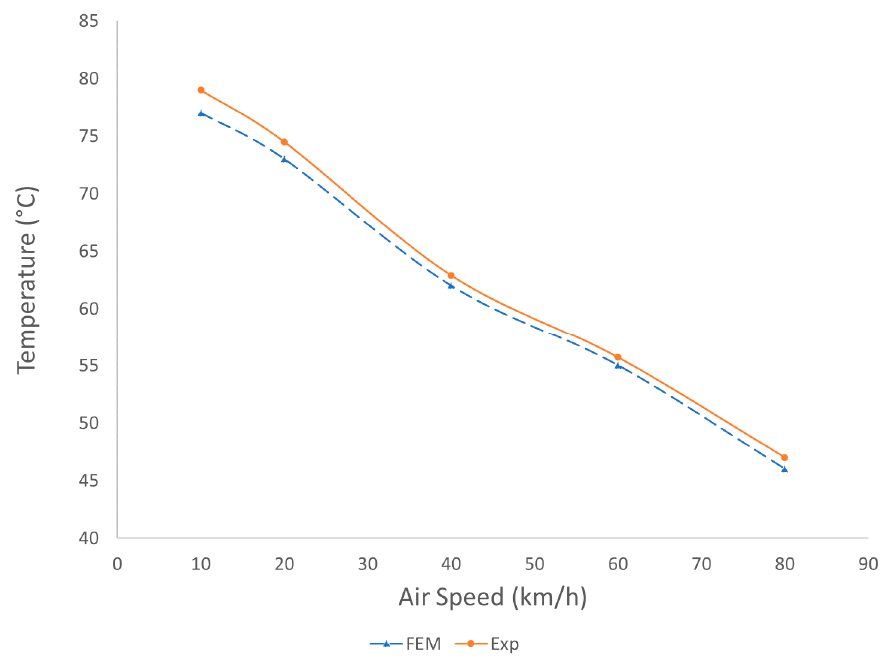
Figure 10. Decrease in temperature when used to drive at various speeds.